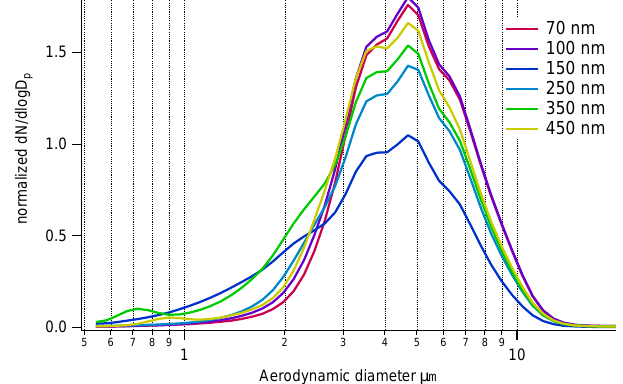
Figure 1. Droplet size for monodisperse AS particles. Concentra- tions ( y axis) were normalized by dividing the concentrations by the total particle concentrations upstream of the m-VACES (13– 35#cm − 3 ) .